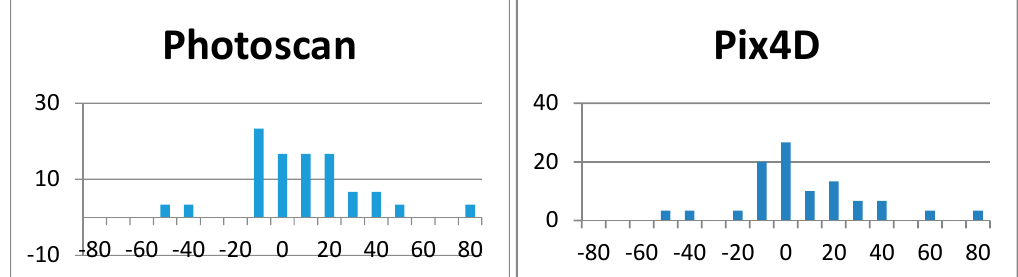
Table 7. Results of the volume measurements.